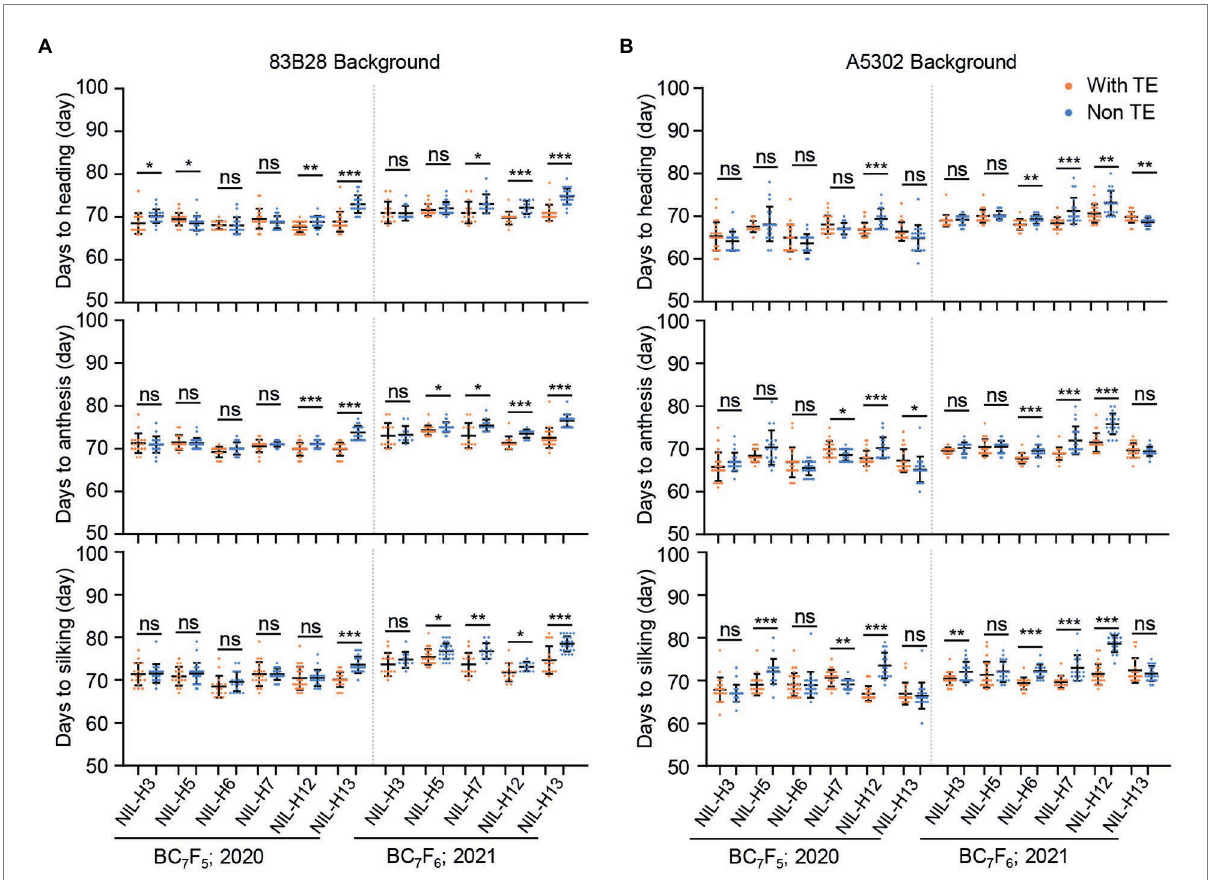
FIGURE 2 Twenty-two pairs of NILs in 83B28 (A) and A5302 (B) background were investigated for flowering time in 2020–2021 Beijing under long-day conditions. The genotypes of every pair of NILs were with TE ZmCCT homozygotes: H1/H1 , and non-TE ZmCCT homozygotes: H3/H3 , H5/H5 , H6/H6 , H7/H7 , H12/H12 , or H13/H13 . Values are mean ± standard deviation (s.d.). Asterisks indicate significant differences between H1/H1 plants and the other genotypes (two-tailed paired Student’s t-test , * p < 0.05, ** p < 0.01, *** p < 0.001, ns, not